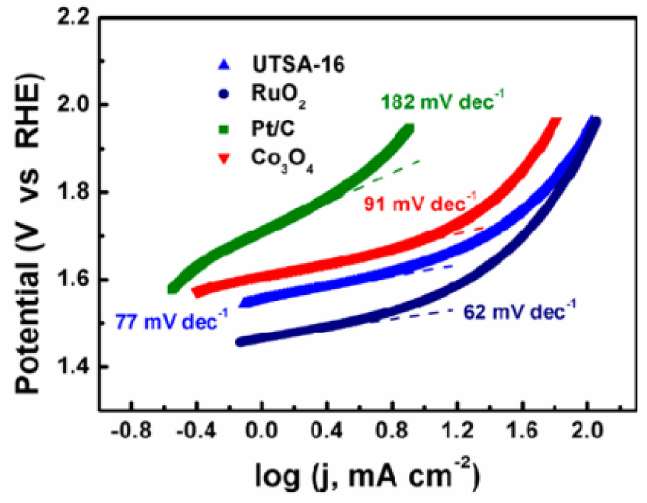
Figure 16. Polarization curve-derived Tafel plots of the UTSA-16, benchmark RuO 2 , Pt/C, and Co 3 O 4 counterpart. Reproduced with permission from [55].